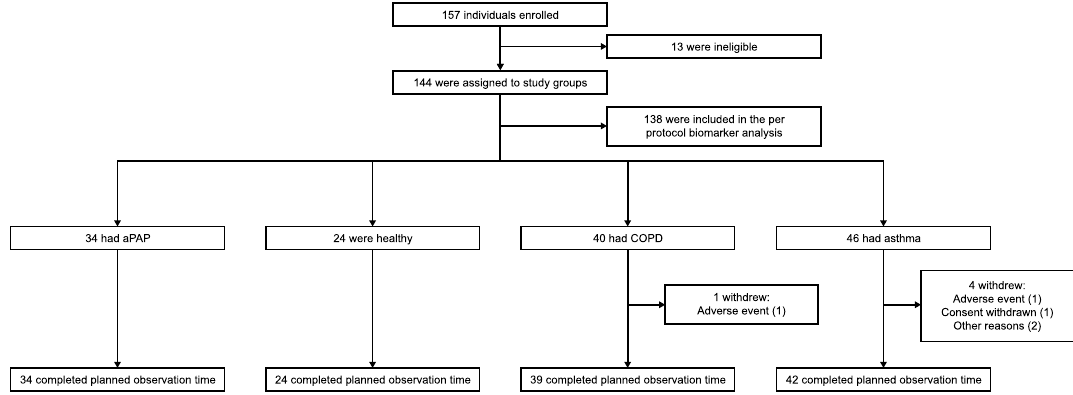
Figure 1. Study groups and disposition. aPAP, autoimmune pulmonary alveolar proteinosis; COPD, chronic obstructive pulmonary disease.